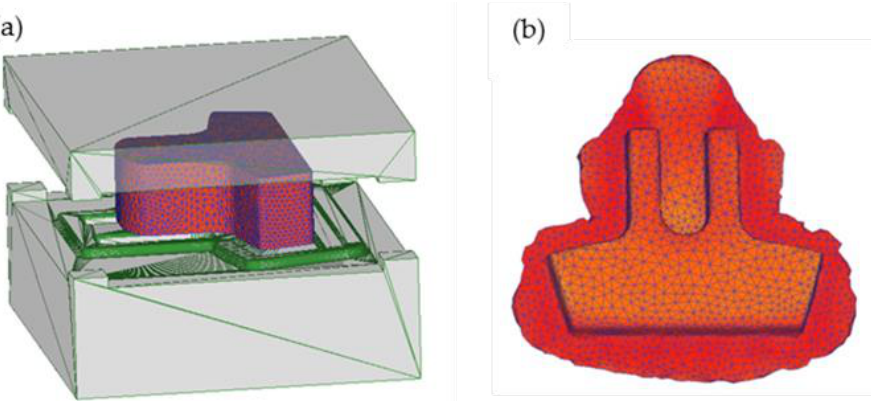
Figure 11. Contour line optimization of pre-formed blank.